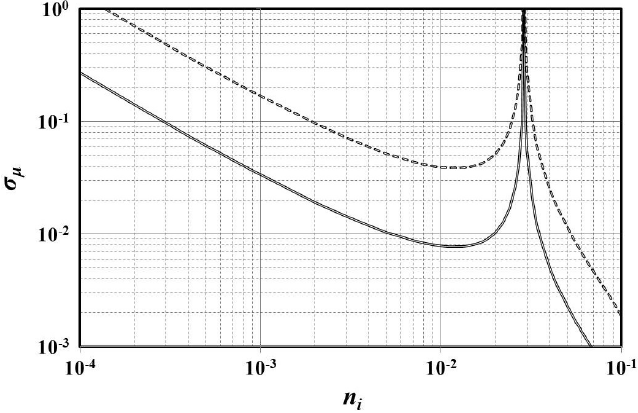
Figure 4. Maximum permissible relative error, σ µ , as a function of n i for ultimate refractometric precision δ n r / n r = 2 × 10 − 5 , when δθ c = 20 µ rad (solid line), and standard refractometric precision δ n r / n r = 10 − 4 , when δθ c = 100 µ rad (dashed line). A sample with n r = 1.5 and a prism with n o = 2 are